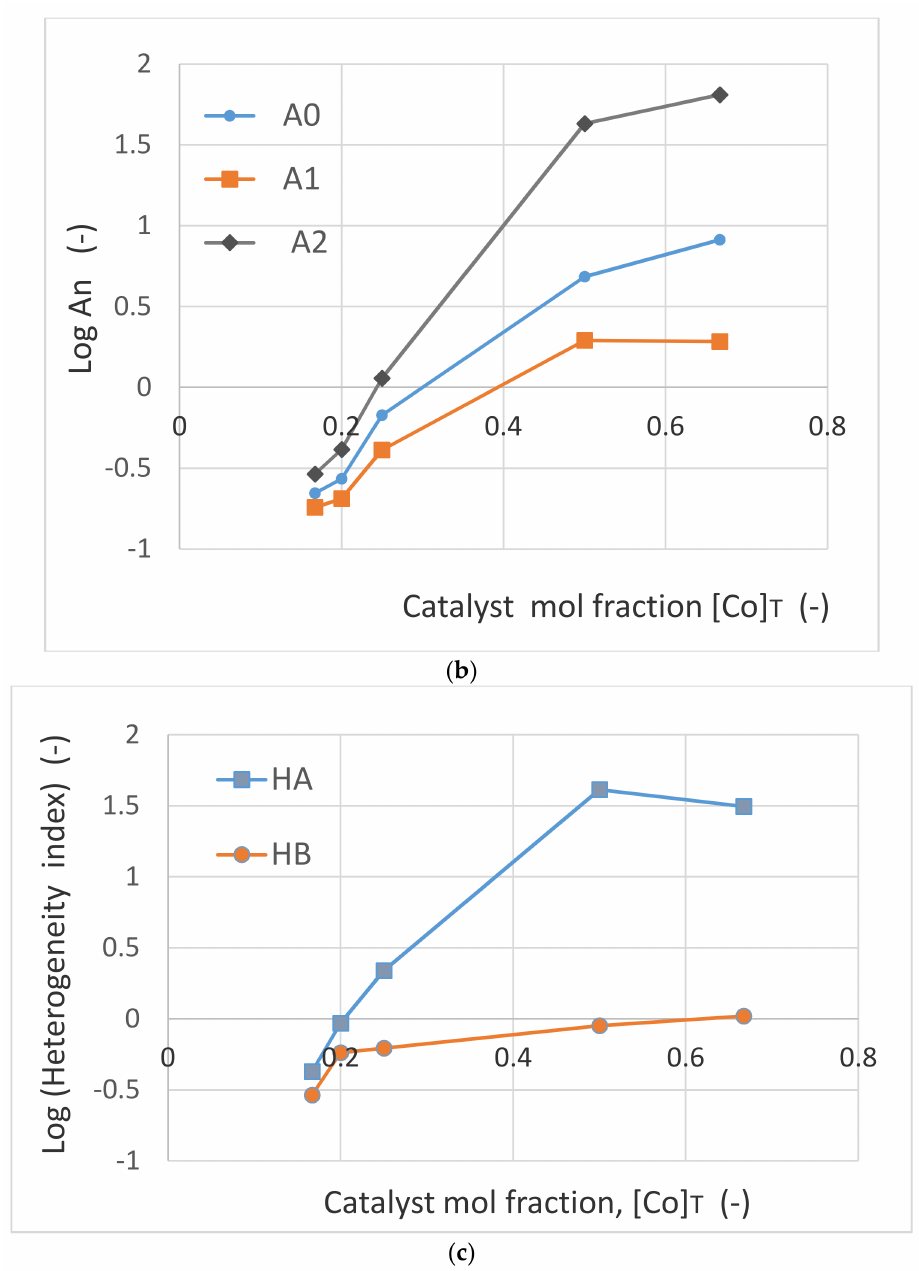
Figure 23. Summary of the characteristics of Co / Si = X catalyst surface as a function of theoretical (feed) catalyst concentration, [Co] T = X / (1 + X). ( a ) Variation of concentration of oxygen, [O] n (n = 0, 1, 2) with the feed catalyst concentration [Co] T at various locations represented by n = 0, 1, 2 (n = 0, average molar concentration; n = 1 where cobalt concentration is the lowest and n = 2 where cobalt concentration is the highest); ( b ) Variation of Log (Cobalt / Silica ratio), Log A n , (A n = [Co] n / [Si] n ) with theoretical cobalt concentration, [Co] T at 3 locations represented by n = 0, 1, 2; ( c ) Variation of Log (Heterogeneity indices), H A (catalyst heterogeneity index) and H B (lattice oxygen heterogeneity index) with theoretical cobalt